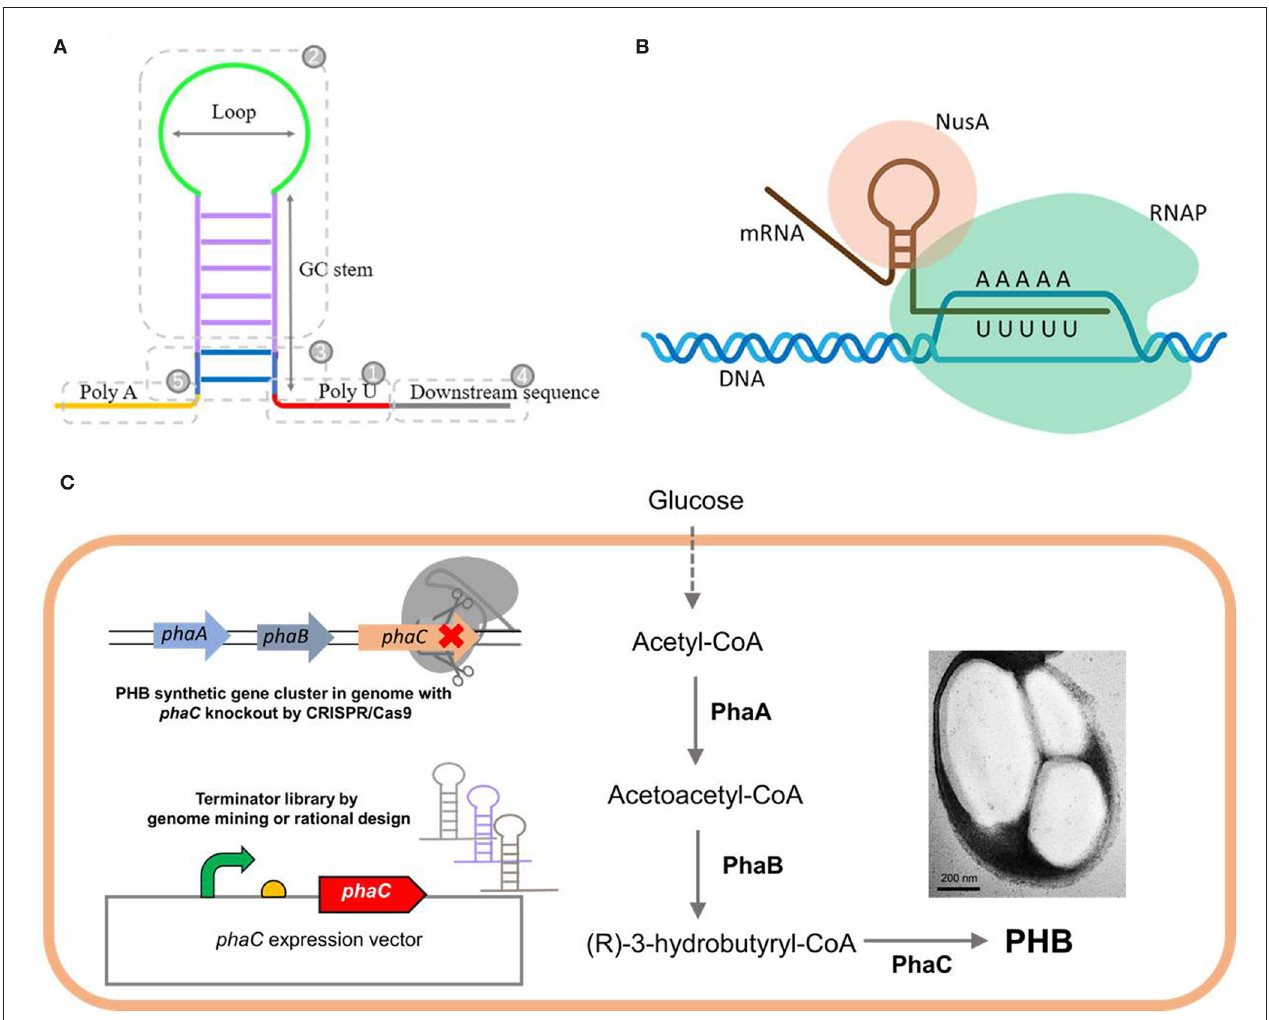
FIGURE 1 | The typical structure (A) of an intrinsic terminator and its canonical mechanism for transcription termination (B) , as well as the schematic design of this study (C) . (B) Rho-independent termination does not require any protein factors while it will be enhanced by an accessory proteins NusA. (C) The native or engineered terminators were employed to regulate the PHB production, one of the environmentally friendly biomaterials accumulated intracellularly from glucose by three key enzymes: β -ketothiolase (PhaA), acetoacetyl-CoA reductase (PhaB), and PHA synthase (PhaC). The phaC gene in the genome of H. bluephagenesis TD01 was deleted by CRISPR/Cas9, and functionally rescued by phaC expression vectors regulated by terminators with different